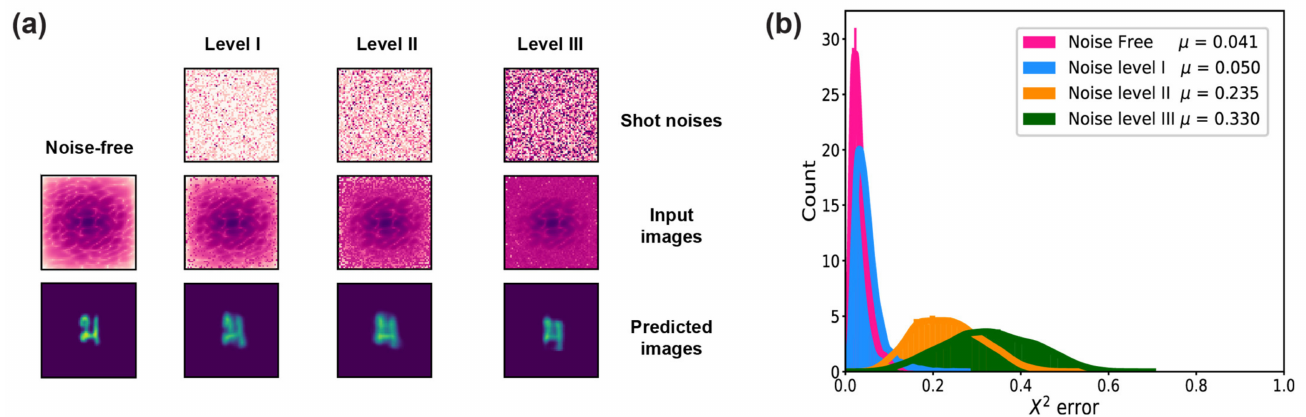
Figure 6. ( a ) The first row shows the shot noises that result in the noisy input images in the second row. The third row shows the predicted images based on the corresponding input images. ( b ) The histograms of X 2 errors show the performances of four cases defined in ( a ).